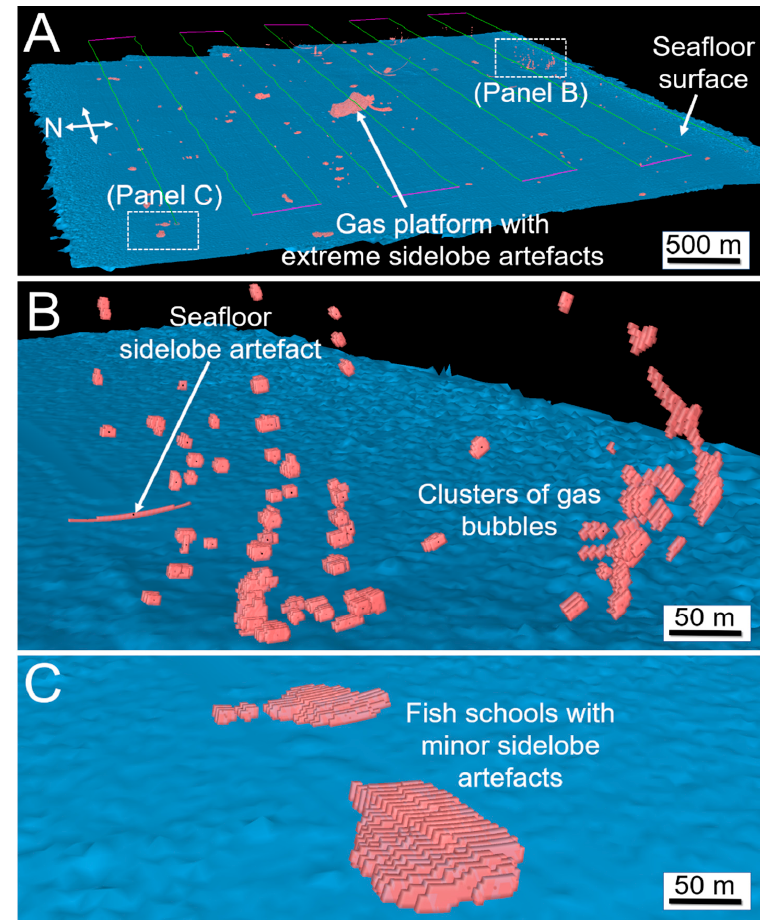
Figure 7. 3D visualisation of the slices (red) created from Survey 1. ( A ) Overview of the entire sur- vey. ( B ) Clusters of gas bubbles rising from the seafloor in the SE corner of the survey area. ( C